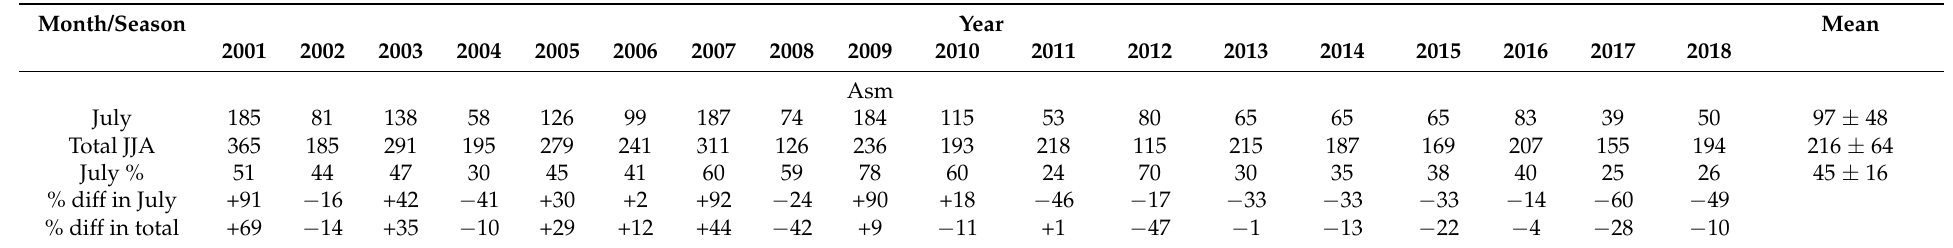
Table 1. Annual rainfall (mm) in July and total annual rainfall in JJA from 2001 to 2018 over Asmara (Asm) with the mean calculated. The percentage amount of rainfall in July, the percentage difference in July, and total rainfall from the mean (2001–2018) for each year are also given. − indicates % deficit and + denotes % excess of the mean rainfall in July and for the season.